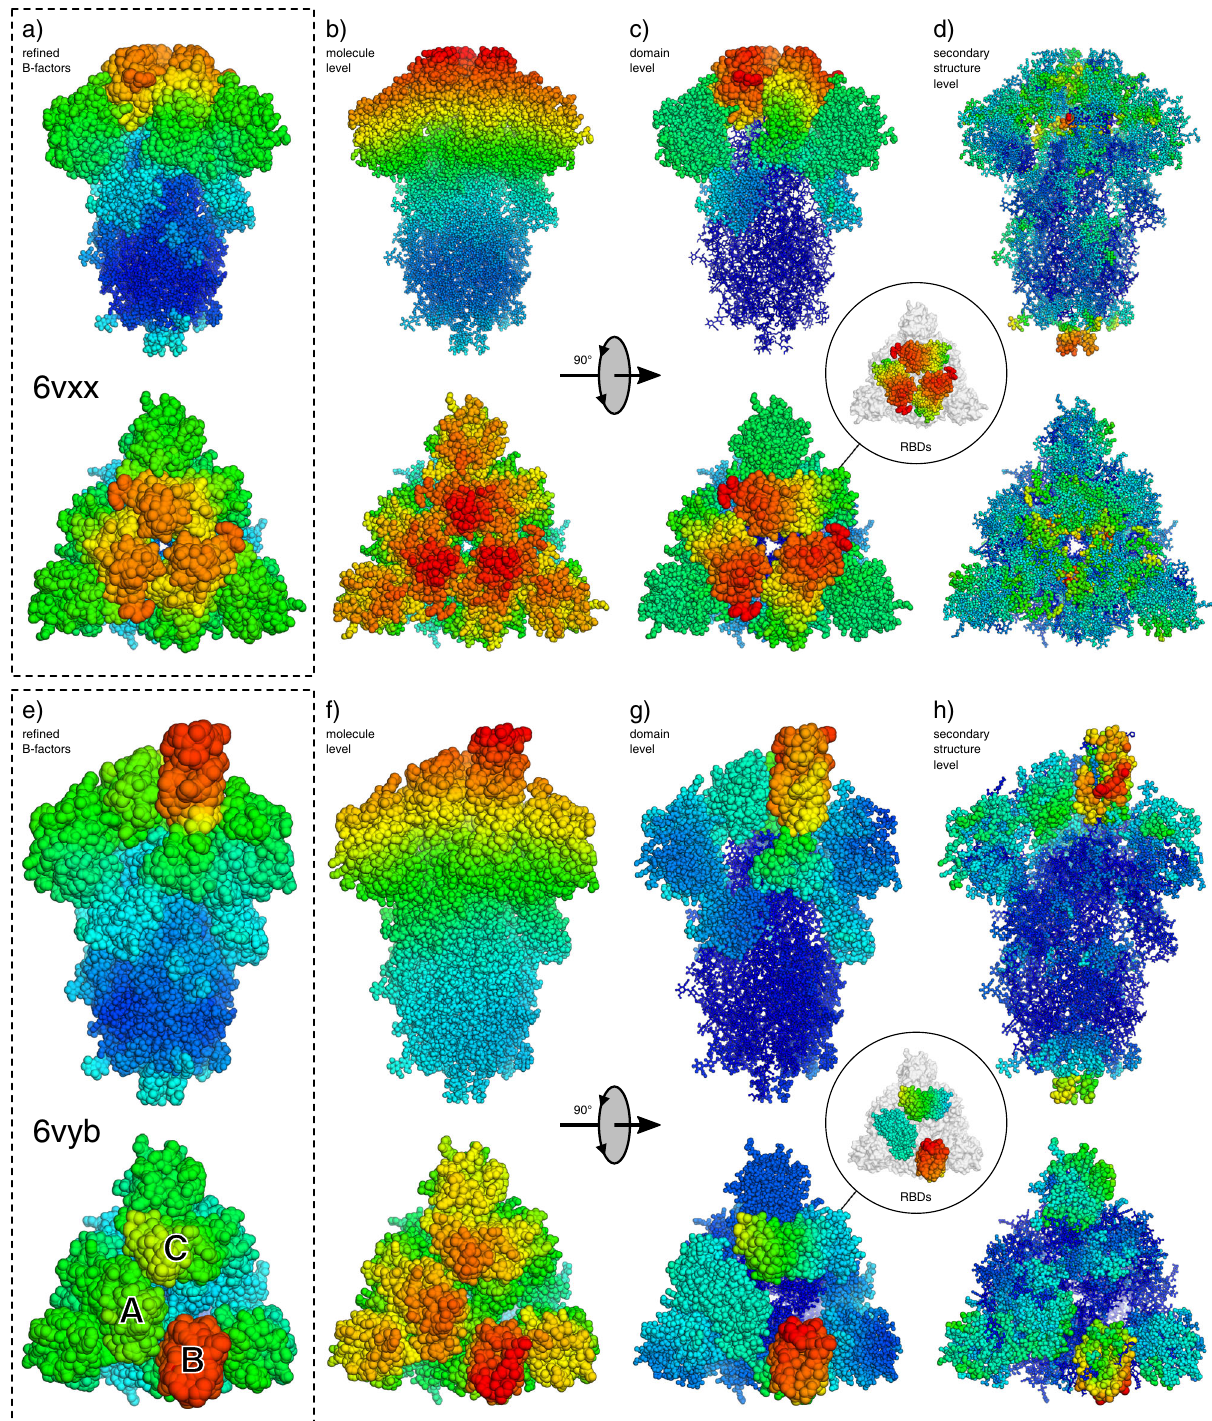
Fig. 5 ECHT decompositions of SARS-CoV-2 surface glycoprotein structures (6vxx & 6vyb). Atoms are shown as lines and ellipsoids, coloured by B-factor for each structure independently from blue (zero) to green to red (maximum). B-factor ellipsoids are contoured at p = 0.95. Side and top views of trimer for ( a – d ) the closed state (6vxx), and ( e – h ) the open state (6vyb). a Deposited structure for 6vxx (2.8 Å resolution; individual i-ADPs, B-factors 3.5 – 102.4 Å 2 ). b – d Disorder components of each ECHT level (maximum B-factor in brackets): b molecule (32.0 Å 2 ), ( c ) domain (45.5 Å 2 ), ( d ) secondary structure (20.7 Å 2 ). ( e ) Deposited structure for 6vyb (3.2 Å resolution; individual i-ADPs, 16.4 – 181.1 Å 2 ). f – h Disorder components of each ECHT level (maximum B-factor in brackets): ( f ) molecule (67.2 Å 2 ), ( g ) domain (85.3 Å 2 ), ( h ) secondary structure (44.3 Å 2 ). b , f The molecular components for both structures show similar pro fi les, with a gradient of disorder across the molecule. c The domain-level disorder reveals hinge-like components for the closed RBDs. g The domain-level disorder reveals conservation of the hinge-like disorder for chain C, but a loss of this component for chain A. Inset images show the disorder for the RBDs only. d , h The secondary-structure level reveals intra-domain fl exibility. Images rendered in pymol 29